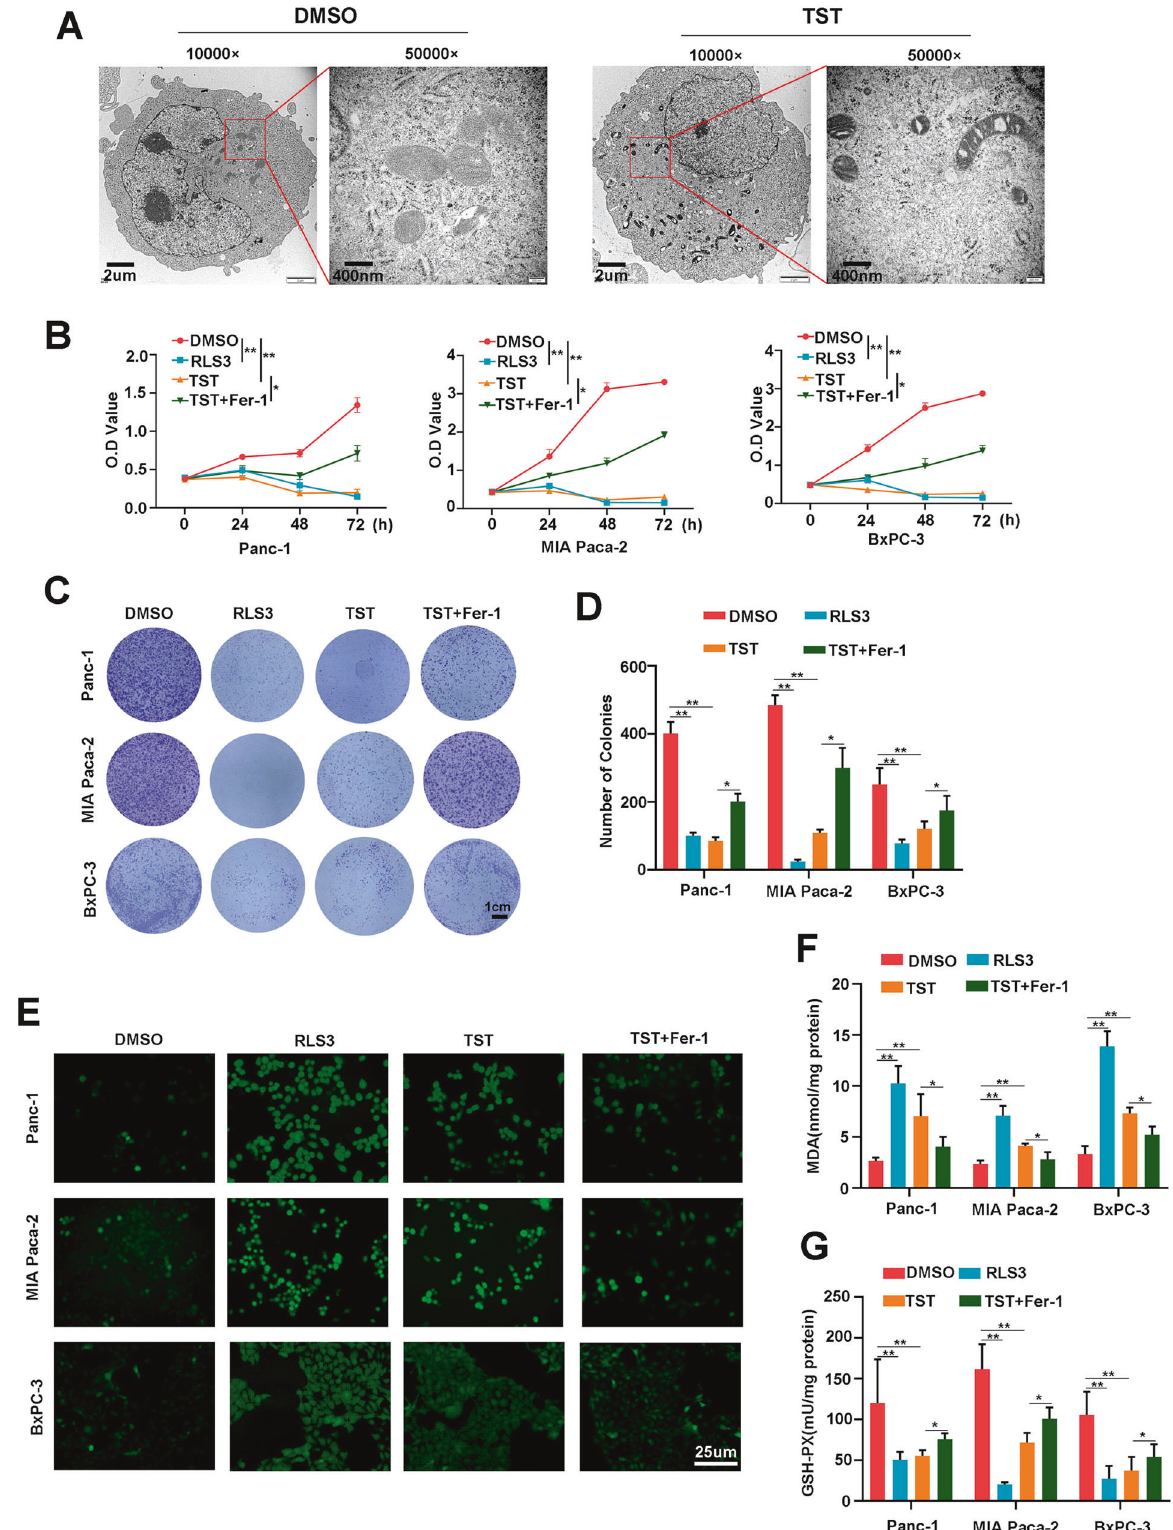
Fig. 2 Thiostrepton promotes ferroptosis in pancreatic cancer cells. A TEM imaging was conducted to control pancreatic cancer cells and TST (2 µM) treated pancreatic cancer cells. B OD value of the CCK-8 assay was conducted at 0, 24, 48, and 72 h using Panc-1, MIA PaCa-2, and BxPC-3 cells from different groups (DMSO, RSL3, TST, and TST + Fer-1). C and D The clonogenesis of pancreatic cancer cells in different treatment groups was measured using the colony formation assay. E ROS levels were detected in pancreatic cancer cells from different treatment groups with a ROS Assay Kit. F and G MDA and GSH-PX levels were detected in the different groups of treated Panc-1, MIA PaCa-2, and BxPC-3 cells. (* P < 0.05 and ** P < 0.01).